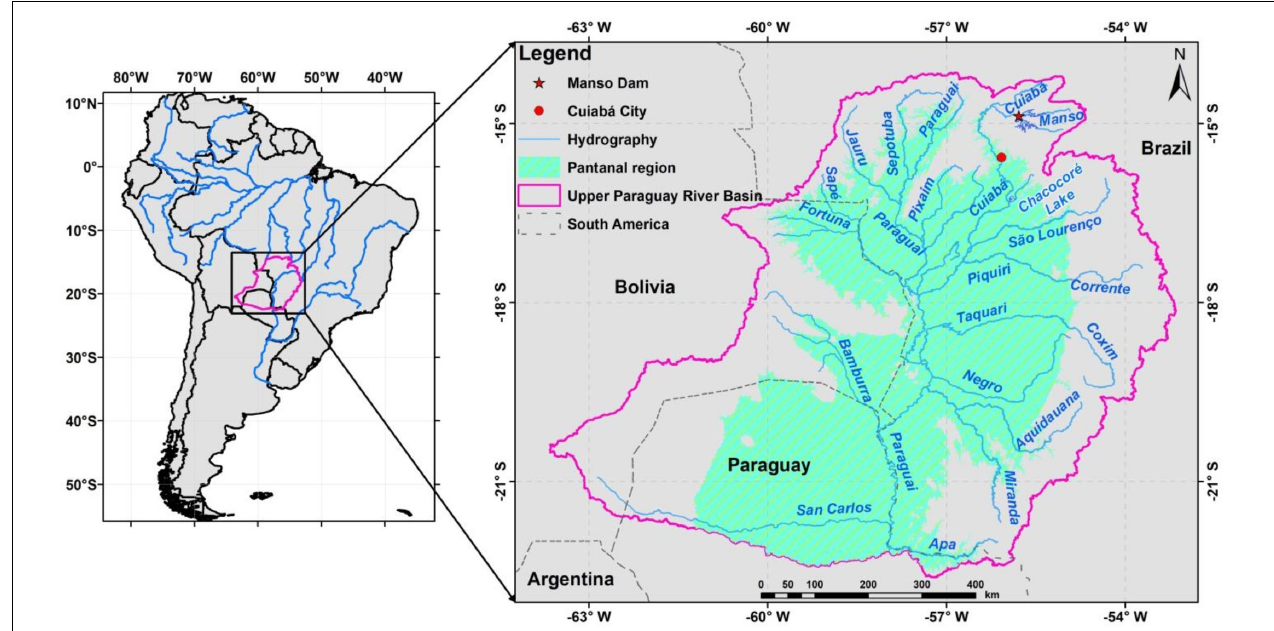
FIGURE 1 | The Upper Paraguay river basin and the Pantanal